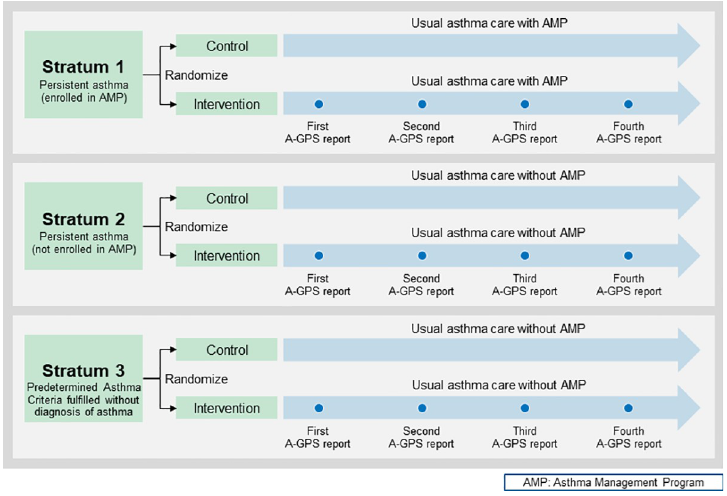
Fig 1. Study design for assessing the comparative effectiveness of A-GPS intervention via an RCT with stratified randomization (see S1 File. The Design and Implementation of Asthma-Guidance and Prediction System (A-GPS) for the definition for each stratum for